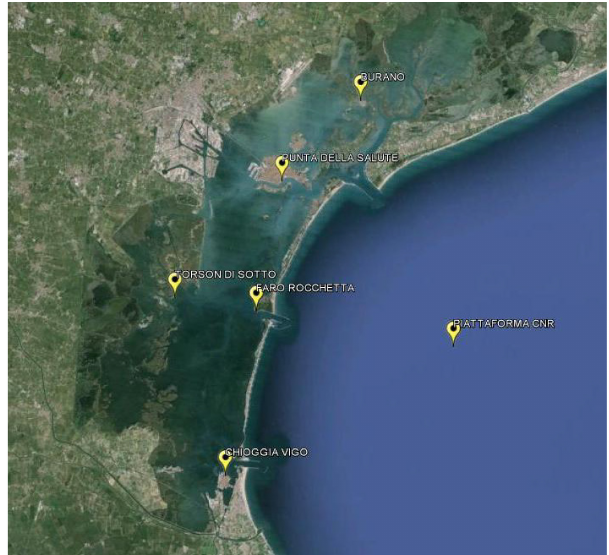
Figure 13. Position of the six tide-gauge instruments considered for the evaluation of the SHYFEM performance. Five stations are situated in the inner of the Venice Lagoon, whilst one is located in the Adriatic